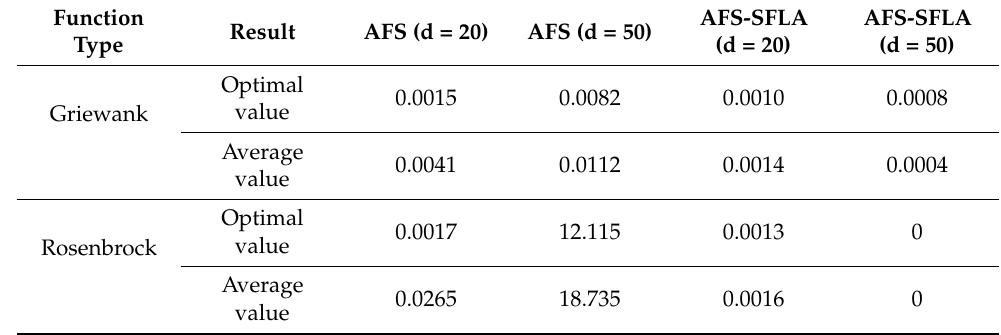
Figure A1. Test results under two benchmark functions ( a ). Optimal solution of Griewank function, ( b ). Optimal solution of Rosenbrock function. Table A1. Testing the algorithm performance in dimension d.